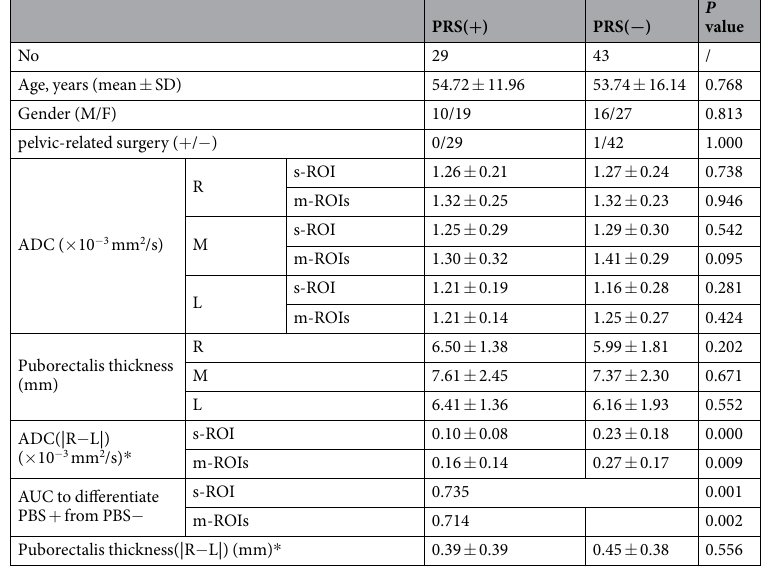
Table 1. Characteristics of paradoxical puborectalis syndrome patients and control patients. ADC: apparent diffusion coefficient; s-ROI: single ROI; m-ROI: multi ROIs; ADC(|R − L|): the absolute difference in ADCs between the right and left branches; puborectalis thickness(|R − L|): the absolute difference in puborectalis thickness between the right and left branches; AUC: area under the curve. * Mann-Whitney